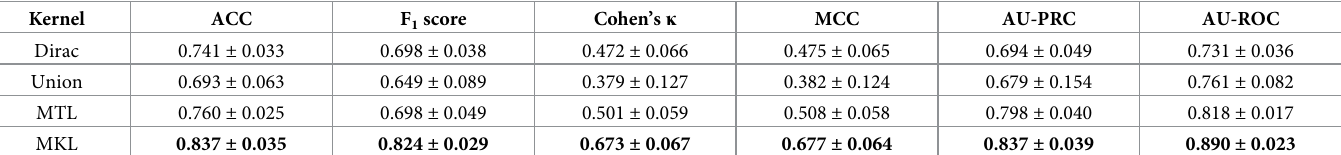
Table 1. Nested cross-validation (outer folds) model performance estimates for na ï ve baseline models (Dirac, Union), our previous state-of-the-art multi-task learning model (MTL), and phenotypic multi-task multi-kernel learning (MKL). Metrics are reported as mean ± standard deviation (SD).